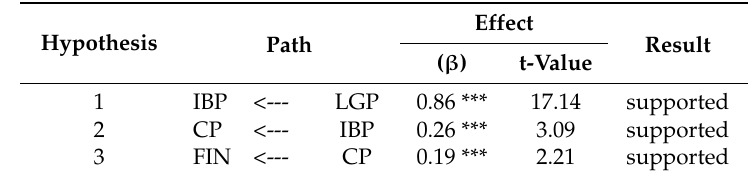
Table 5. Structural Path